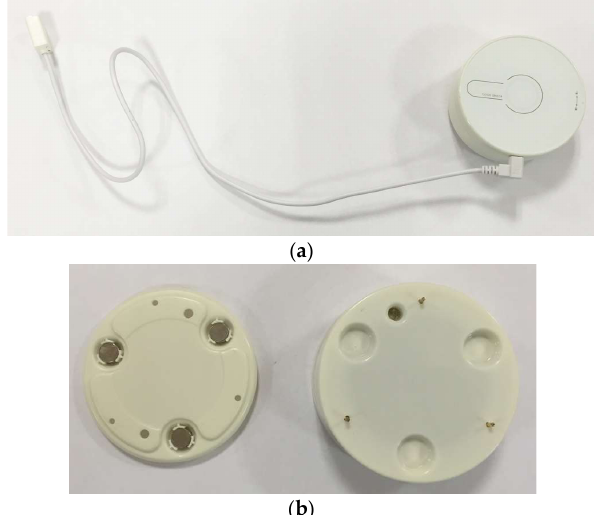
Figure 5. ( a ) Flood sensor packaging; ( b ) Magnetic accessory for installation on a wall.